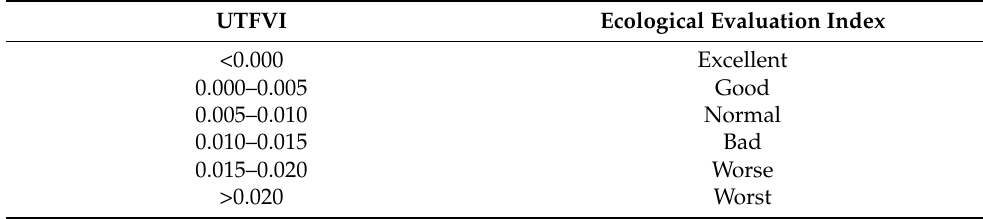
Table 3. Classification of the ecological evaluation